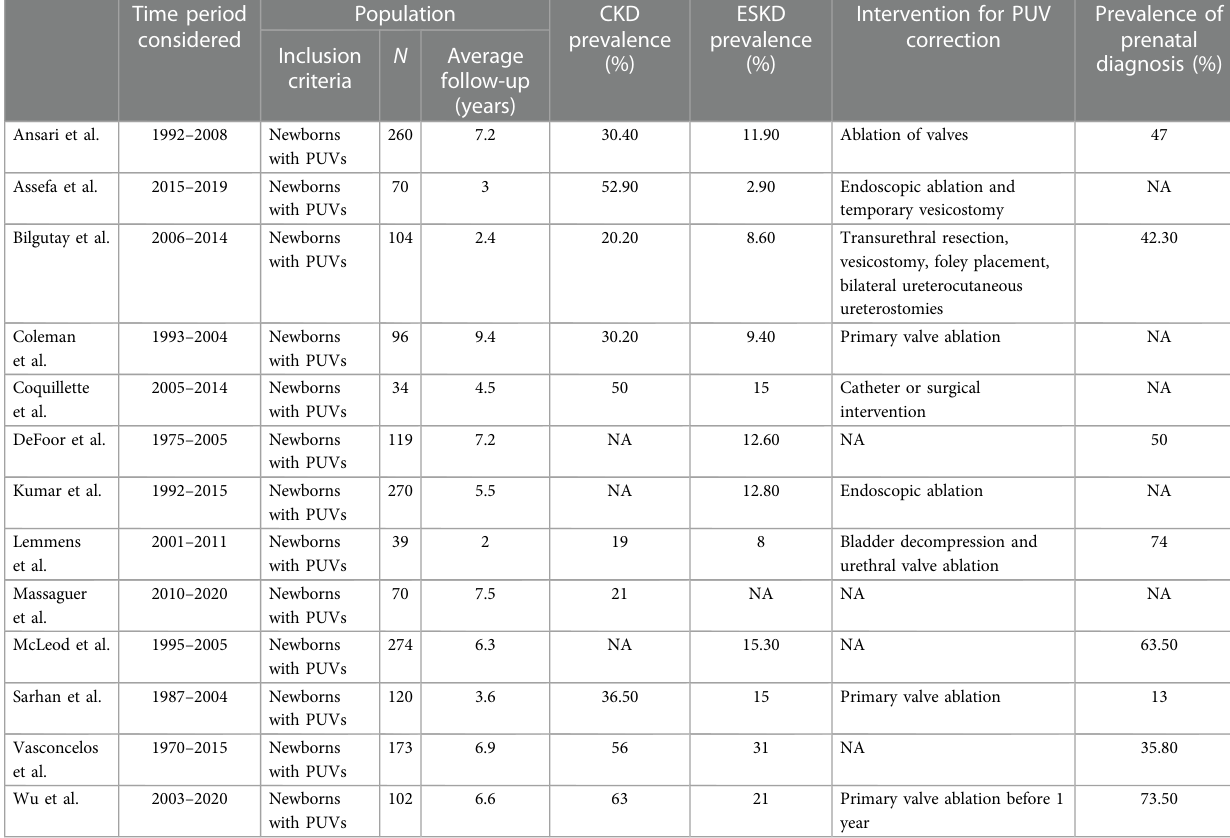
TABLE 2 Population characteristics of studies included in the systematic review and